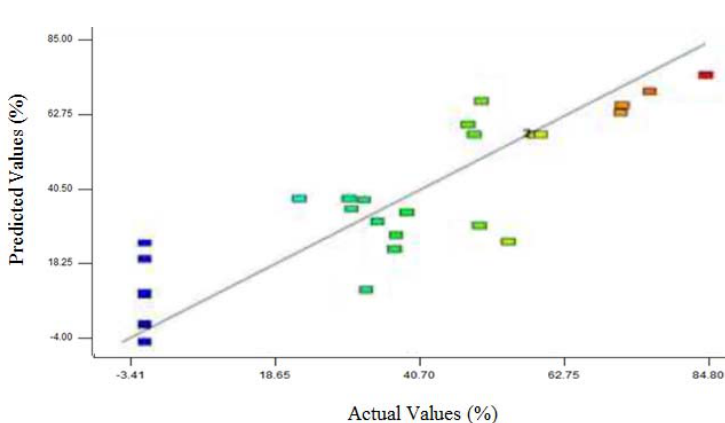
Fig. 4: Actual vs. predicted values for dye adsorption by cleaned clay